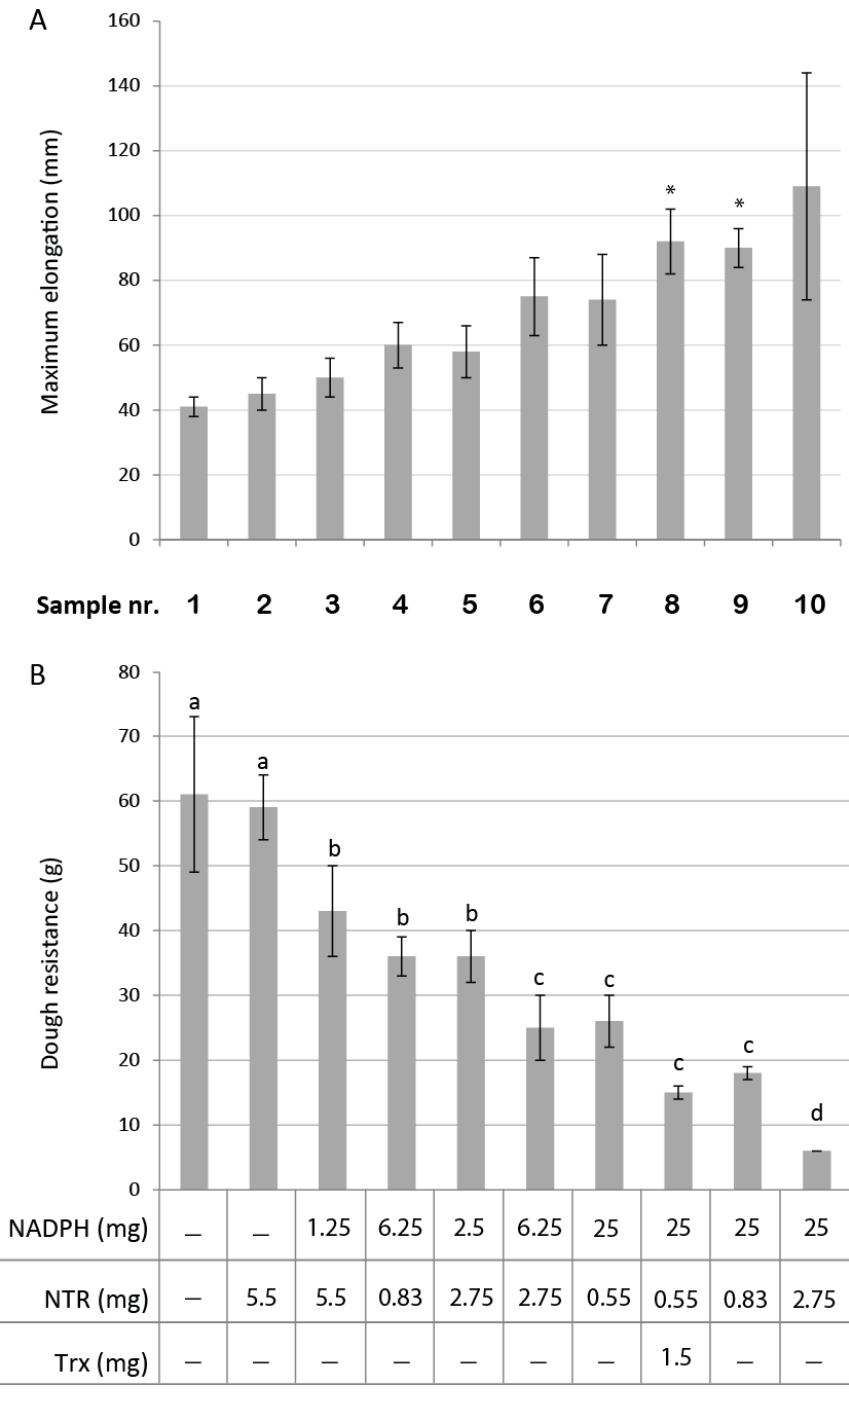
Figure 2. Kieffer rig rheological measurements of dough upon treatment with various amounts of nicotinamide adenine dinucleotide phosphate (NADPH), NADPH-dependent thioredoxin reductase (NTR), thioredoxin (Trx). ( A ) Maximal elongation obtained in mm. Asterisks indicate values that are significantly different from sample 1 (control) (Tukey test, n = 6, p < 0.05). Sample 10 was excluded from statistical analysis due to high variance on the only two measured values. ( B ) Dough resistance in g . Values are the average of 6–8 measurements ± standard deviation, except sample 10, for which n = 2. Different letters indicate significant differences (Tukey test, n = 6, p ≤ 0.05).